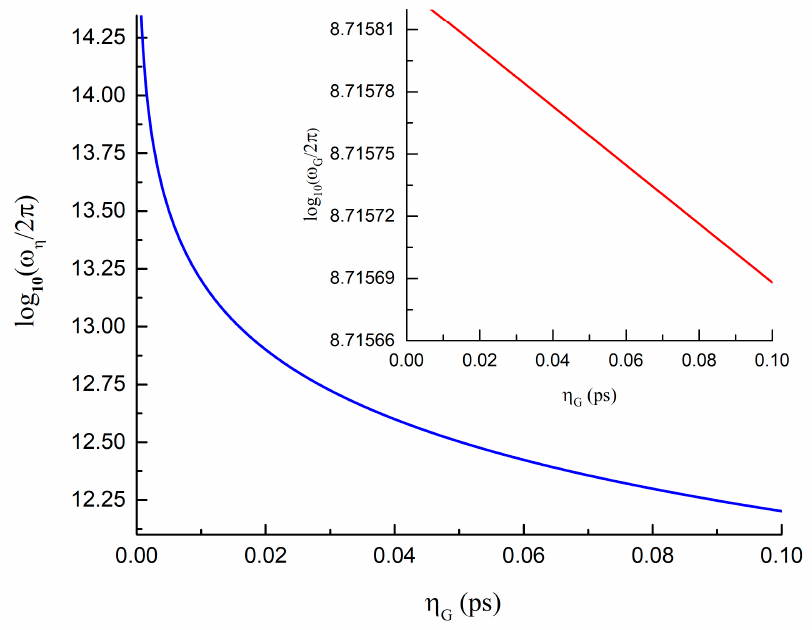
Figure 2. Dependence of the vortex eigenfrequencies ω η and ω G (insert), taken in the logarithmic scale on the nutation parameter η G in permalloy (FeNi alloy) circular nanodot. The nanodot thick- is 10 nm, and the radius is 100 ness is 10 nm, and the radius is 100 nm.